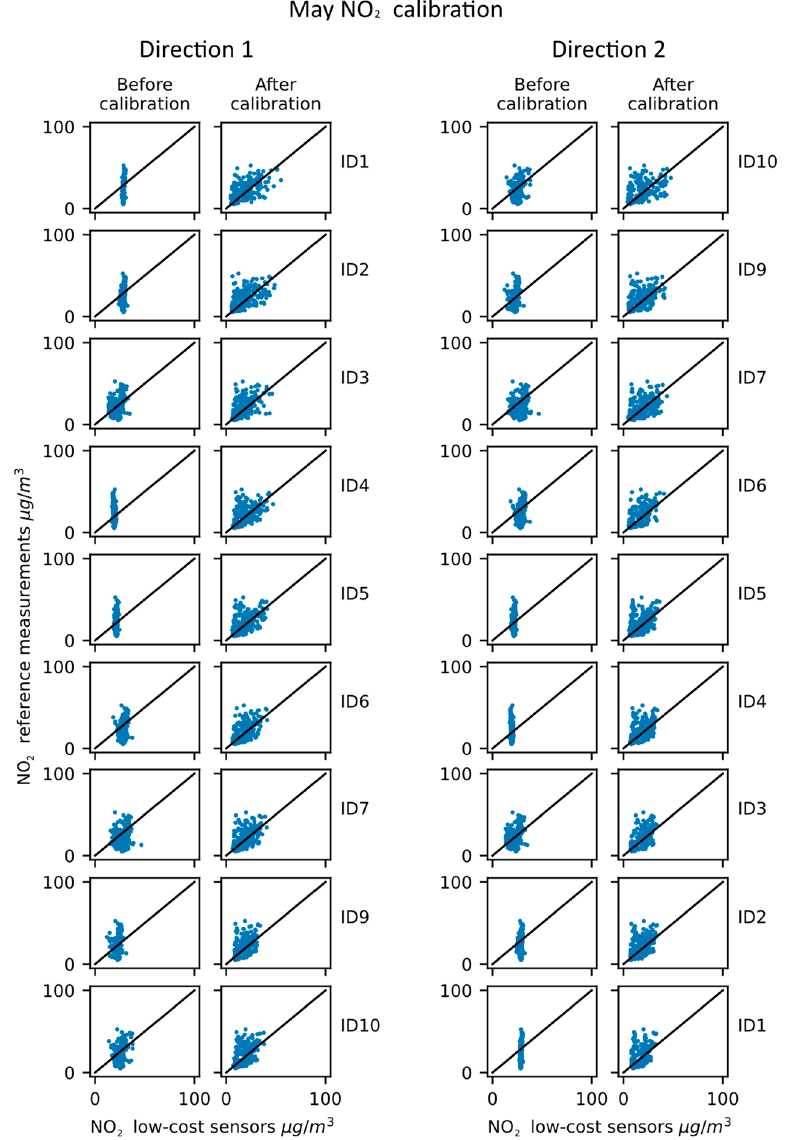
Figure 7. NO 2 calibration propagation—May results.